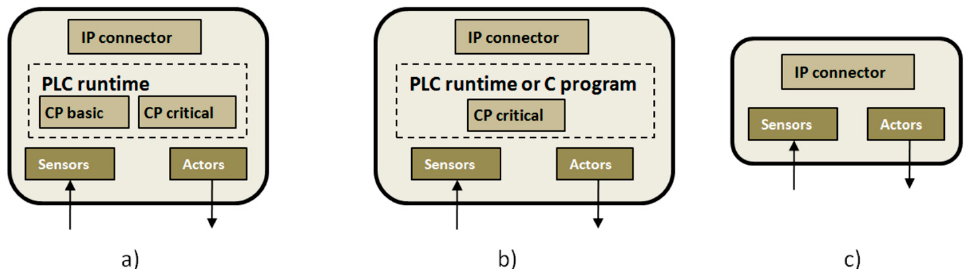
Figure 2. Evolution of a PLC as a CPS component Industrial Control. ( a ) PLC with program components CPb and CPc ( b ) PLC only with CPc component ( c ) The PLC hardware contains only sensors and actuators